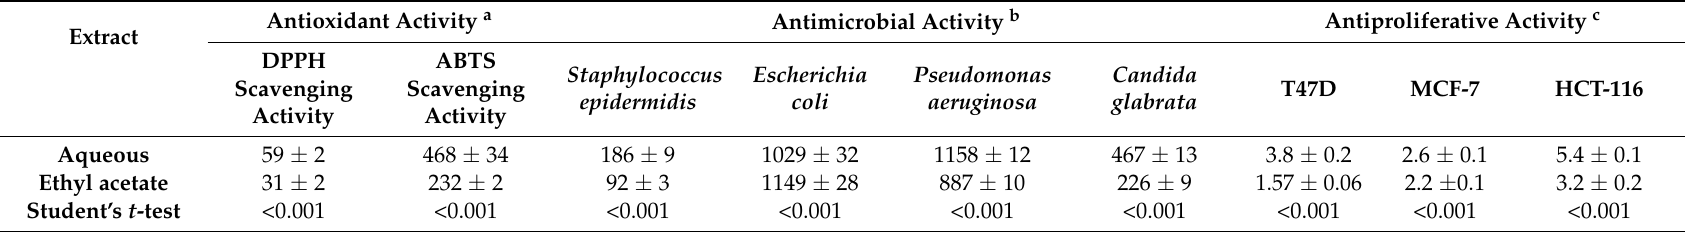
Table 2. Antioxidant, antimicrobial and antiproliferative activities of C. villosus extracts (mean ±